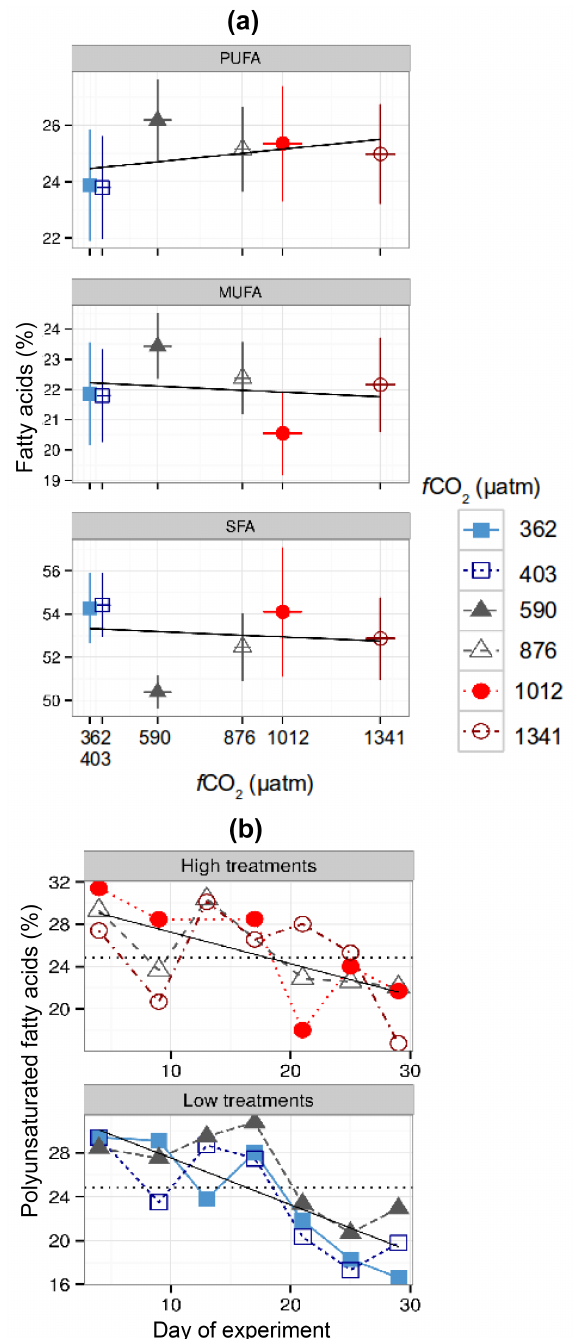
Figure 3. (a) Relative polyunsaturated (PUFAs), monounsaturated (MUFAs) and saturated (SFAs) fatty acids content in the seston as a function of f CO 2 between days 1 and 29. The x axes show the mean f CO 2 measured during the sampling period, bars shows stan- dard error. (b) Relative PUFA composition of the seston showed over time in the 876, 1012 and 1314µatm f CO 2 levels (high CO 2 treatments) and the 362, 403 and 590µatm f CO 2 levels (low CO 2 treatments). Horizontal dashed line indicates the position of the overall mean PUFA